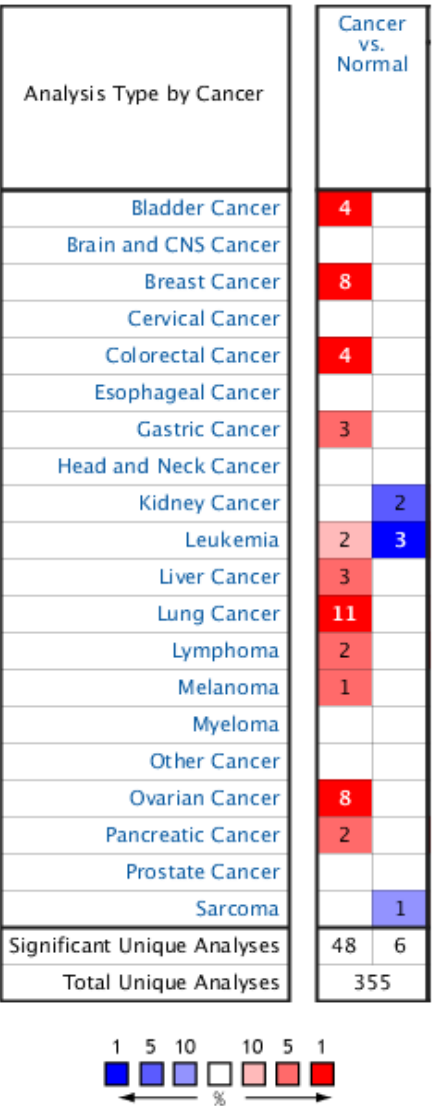
Figure 1. Differential mRNA level of HMGA1 in 20 types of cancer compared to matched normal tissue in the Oncomine. Significantly ( p < 0.05) increased and decreased levels of HMGA1 are indicated in red and blue, respectively. The intensity of cell color is determined by the best gene rank percentile for the analyses within the cell. The number in each cell represents the number of analyses that meet the given thresholds within the analysis and cancer types.